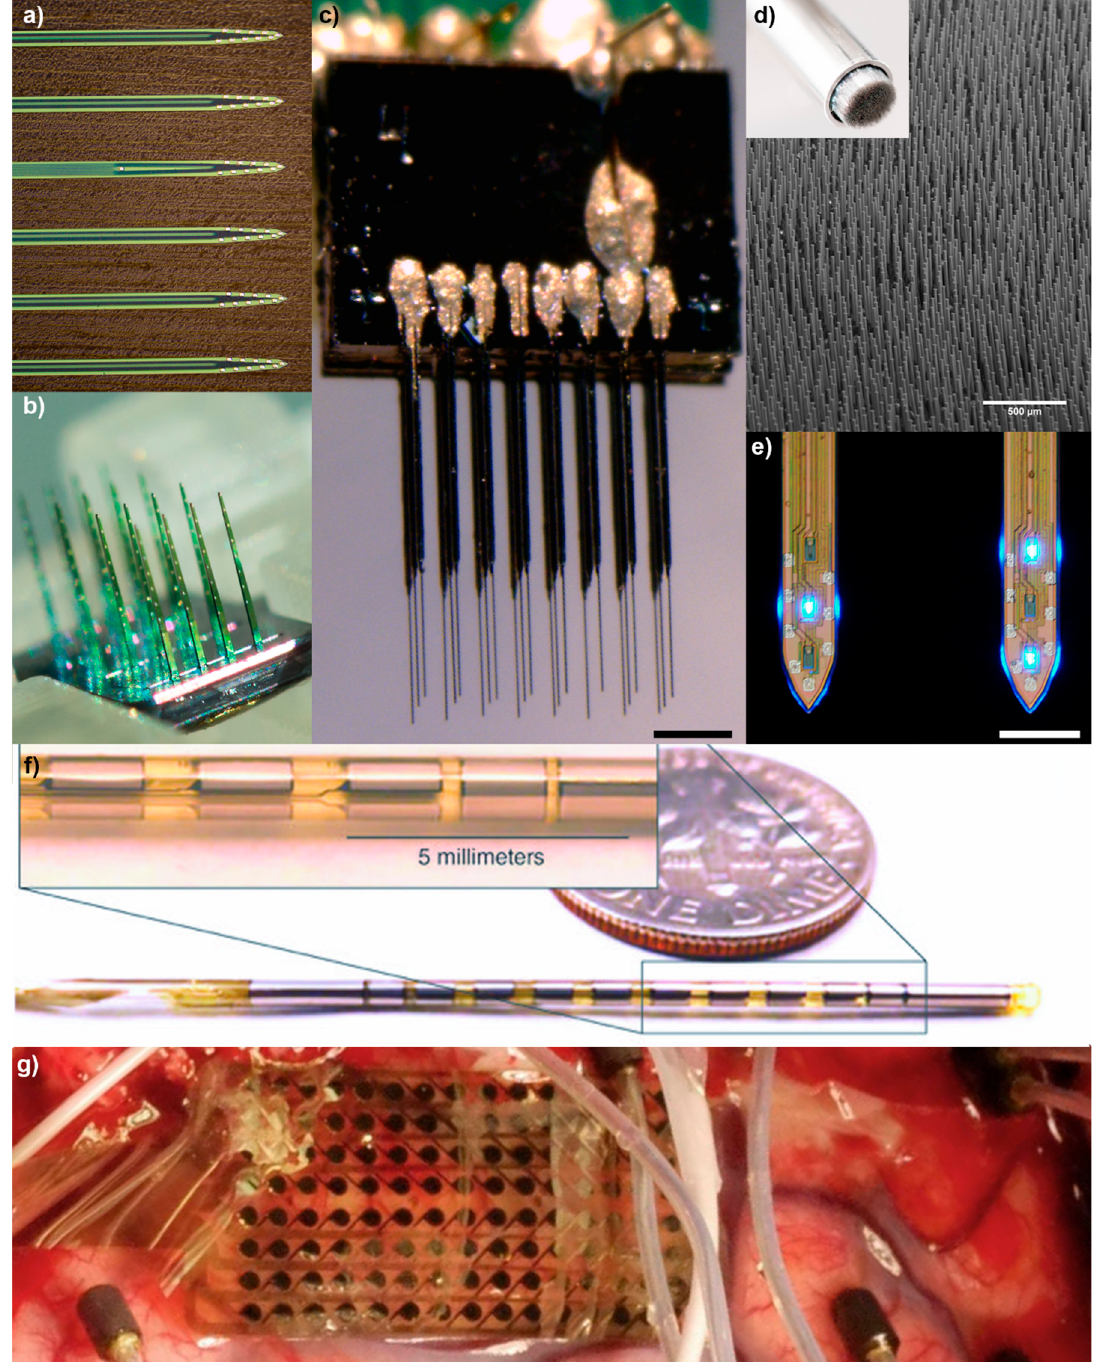
Figure 2. Advances in microscale neural interfaces: ( a ) 64-channel Buszaki Array (Neuronexus); ( b ) 128-channel Matrix Array (Neuronexus); ( c ) 24-channel ultra-small carbon fiber array on silicon stacks (courtesy of Paras Patel/Cynthia Chestek), scale = 100 μ m; ( d ) high-density ultra-small microwire array (Paradromics Inc., San Jose, CA, USA), scale = 500 µ m; ( e ) µ LED silicon optoelectrode (courtesy of NeuroNex MINT Hub at University of Michigan, Ann Arbor, MI, USA (http://mint.engin.umich.edu)), scale = 100 µ m; ( f ) a standard-sized 1.27 mm diameter Lawrence Livermore National